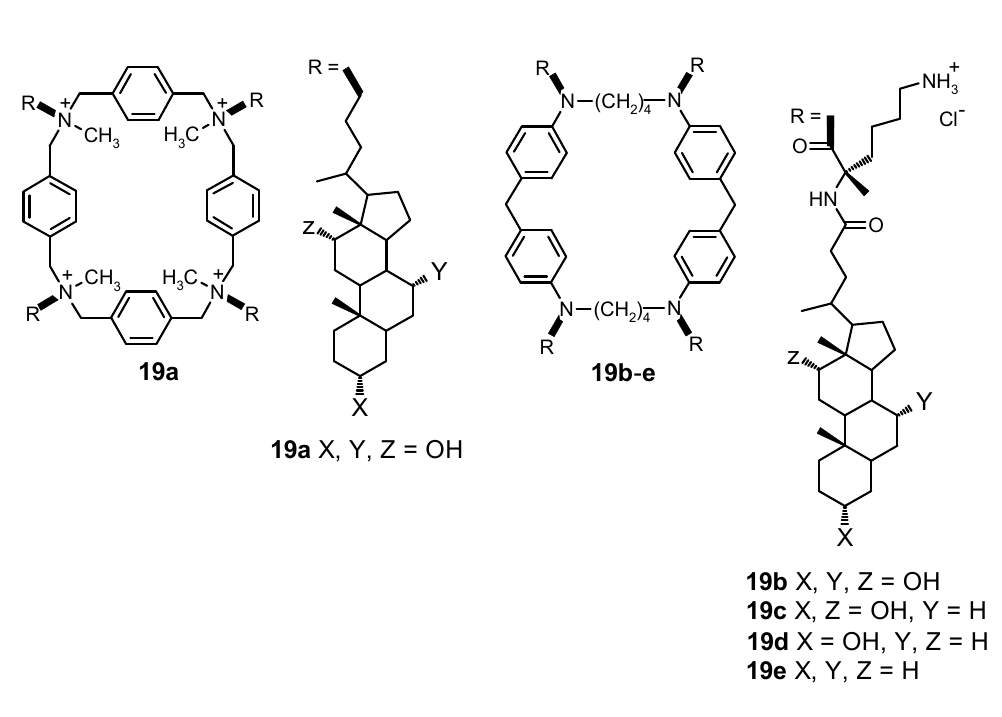
Figure 9. Artificial cell-surface receptors bearing bile acid moieties